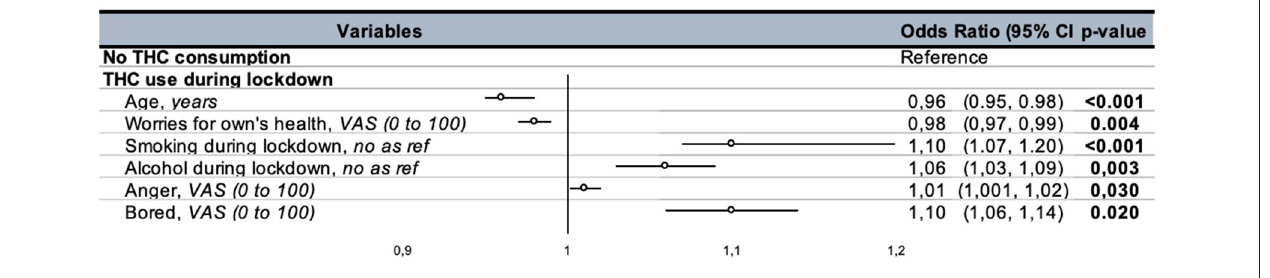
FIGURE 3 | Results of the regression analysis of the use of cannabis during the lockdown. VAS, visual analogue